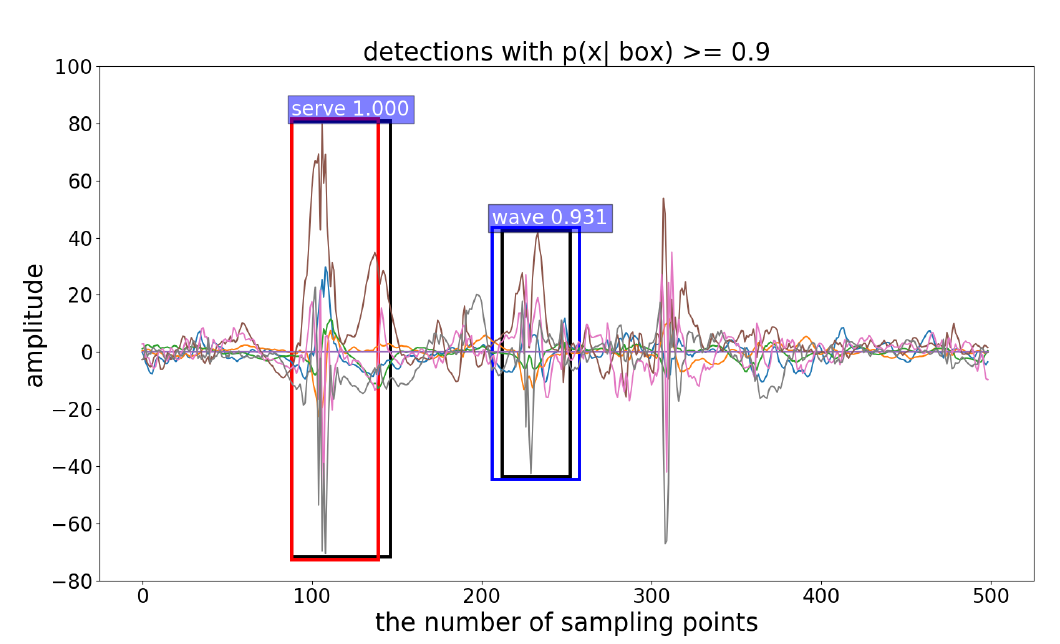
Figure 8. Visualization of the results. The black boxes are the real interval, the red box is the predicted interval of “serving”, and the blue box is the predicted interval of “swinging”. Their confidence levels are marked in the upper left